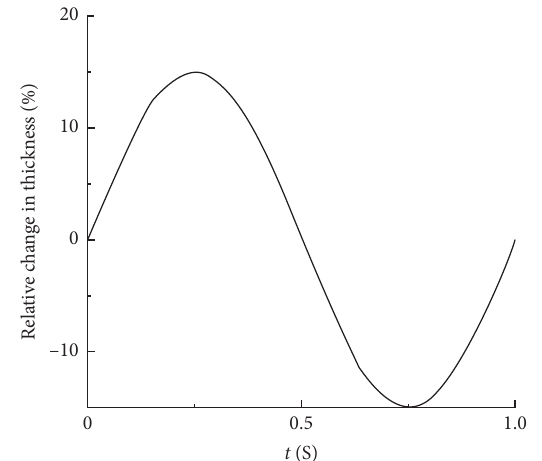
Figure 5: Relative change in thickness over time.